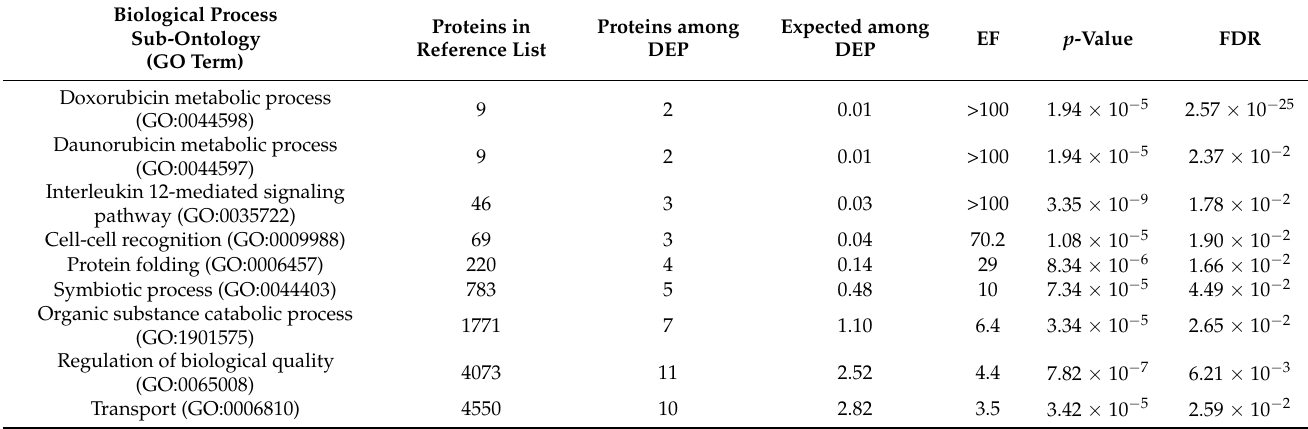
Table 7. The biological process ontology terms overrepresented in the differentially expressed proteins in the T98G human glioblastoma exposed for 72 h to 20 µ g/mL of TiO 2 -NPs. Only the results for FDR p < 0.05 are displayed. DEP = differentially expressed